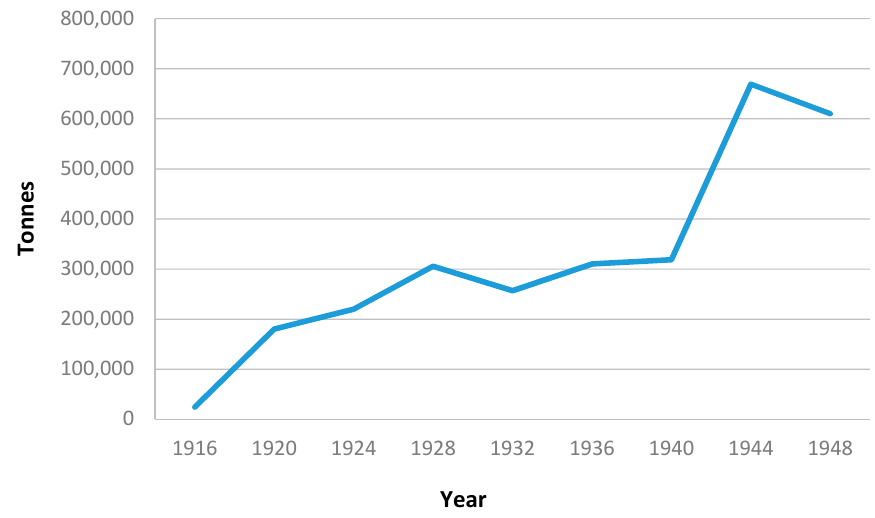
Figure 2. Coal productions in Nigeria over 1916–1948.